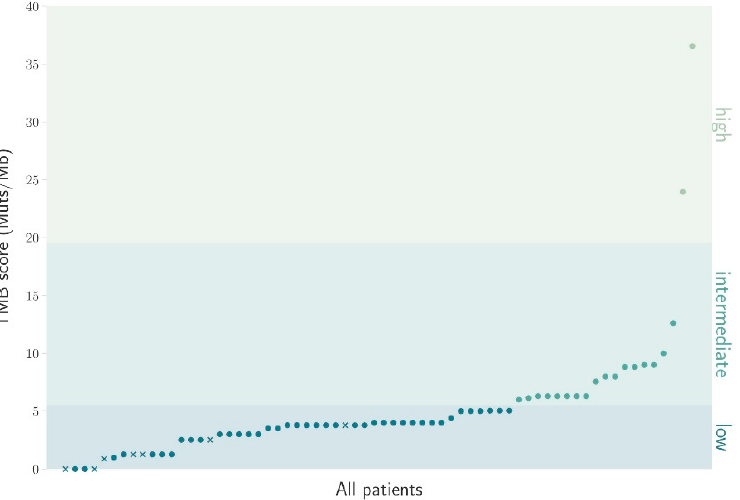
Figure 2. The distribution of patients according to TMB scores ( n = 64). The TMB scores were divided into low, intermediate and high. The classification is based on mutations/mega base according to the FMI CDx test classification.